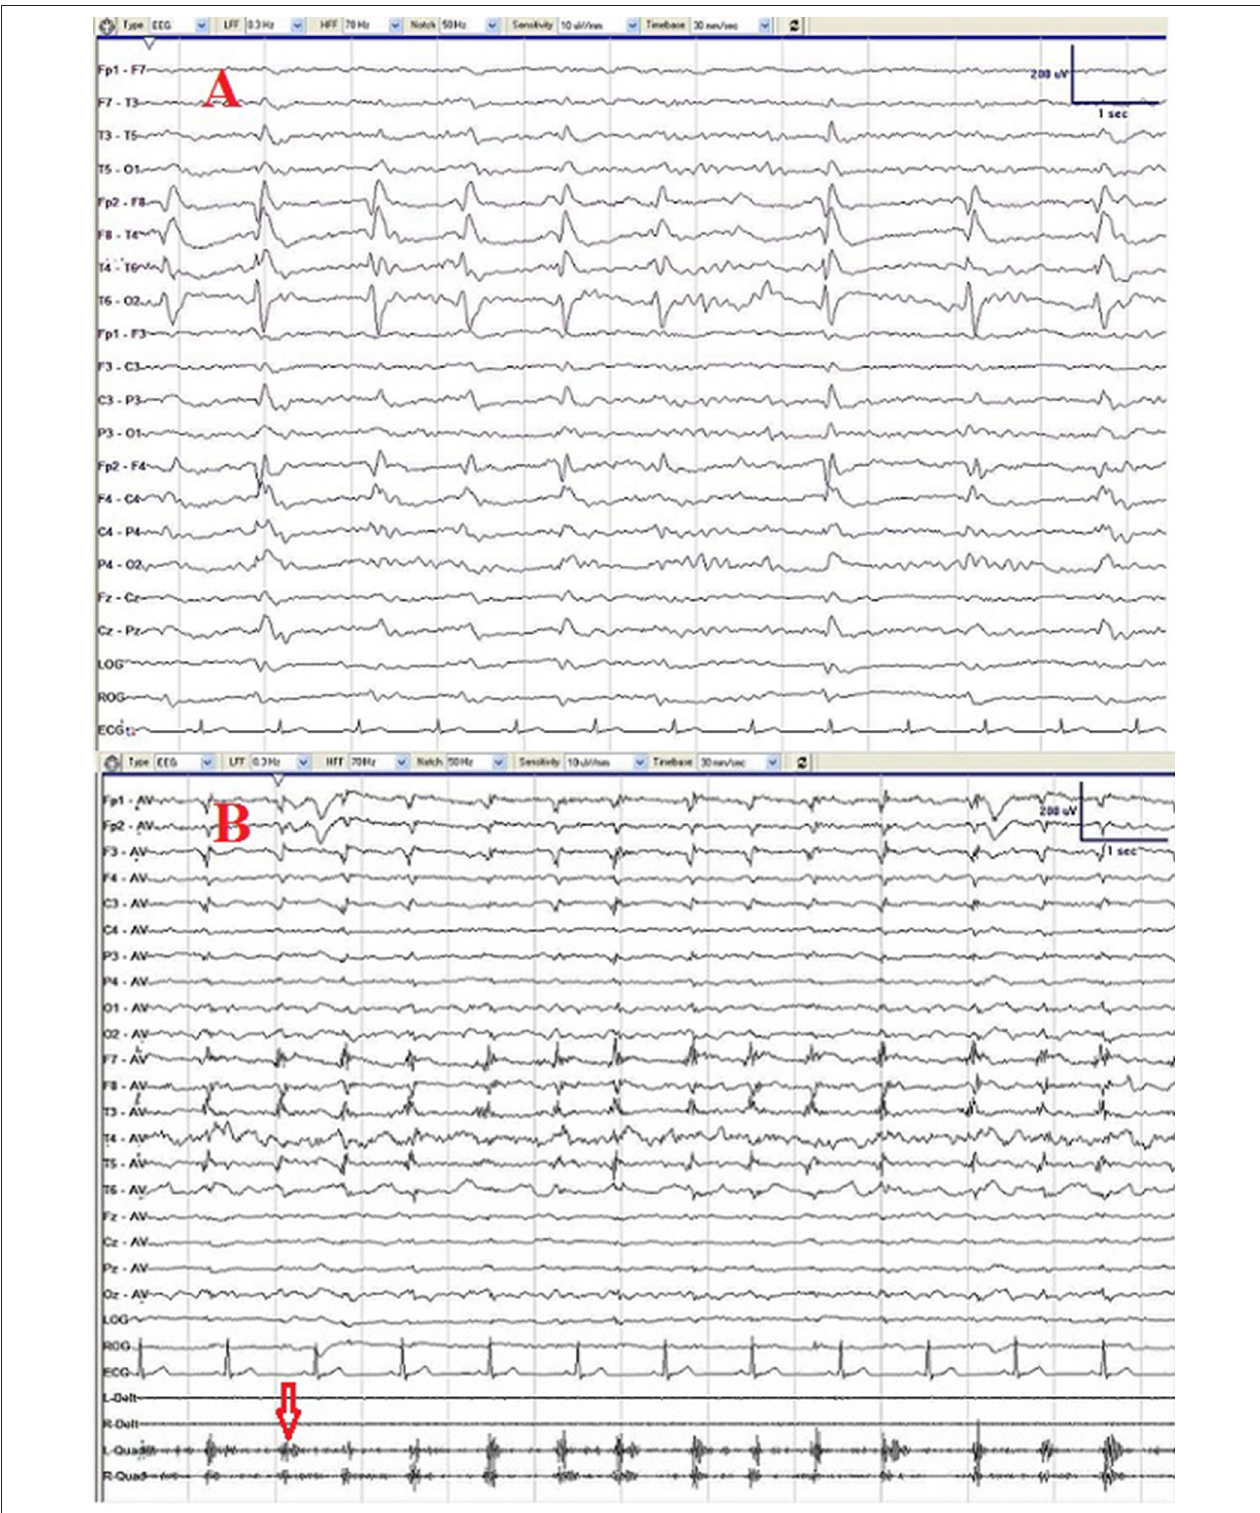
FIGURE 1 | Initial electroencephalogram (EEG) (A) showing periodic lateralized discharge (PLED) consisting of triphasic waves over the right temporal region. After treatment with penicillin for 2 courses, PLED disappeared and repeated EEG (B) showed only slowing waves and muscle artifacts produced by persisted rhythmic orofacial involuntary movements (red